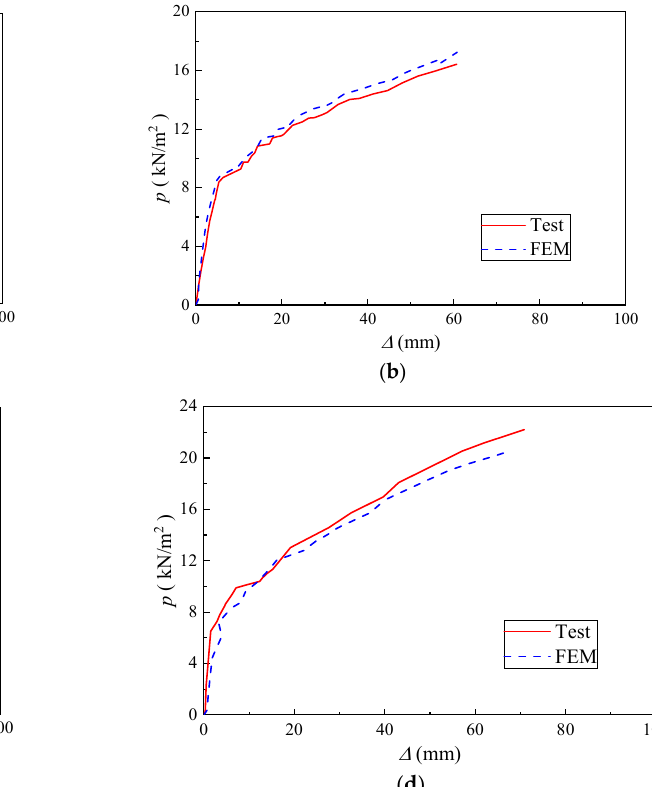
Figure 13. Comparison between FEM and test. ( a ) WP. ( b ) WN. ( c ) WPO. ( d ) WPN.